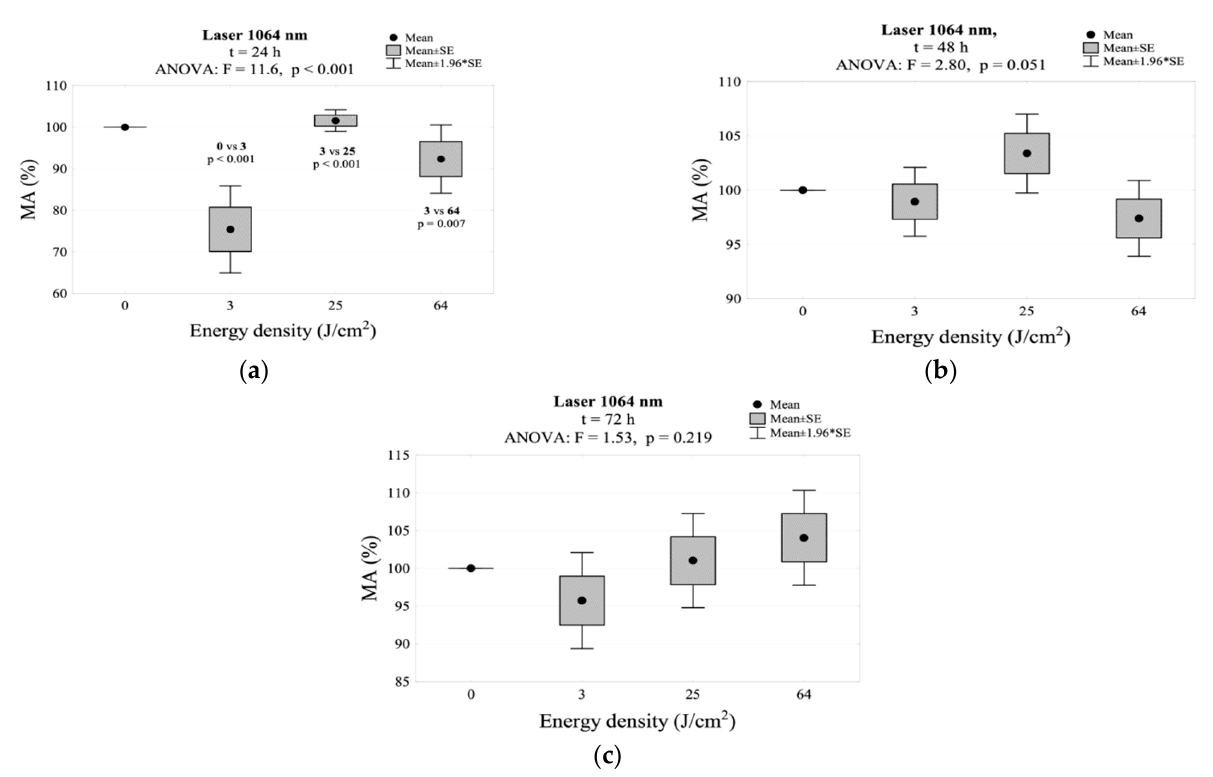
Figure 9. MA values measured: ( a ) 24 h, ( b ) 48 h, ( c ) 72 h after irradiation using the 1064 nm laser. Table 3. Maximum values of mitochondrial activity (MA max ) for various wavelengths ( λ ), amounts of time after irradiation (t) and energy densities (ED) (SD-standard